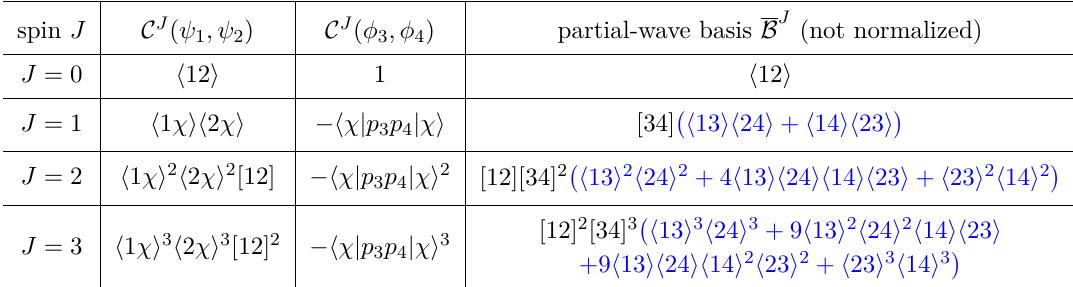
+ p . The factors in blue are the spinor bridge structure which 1 2